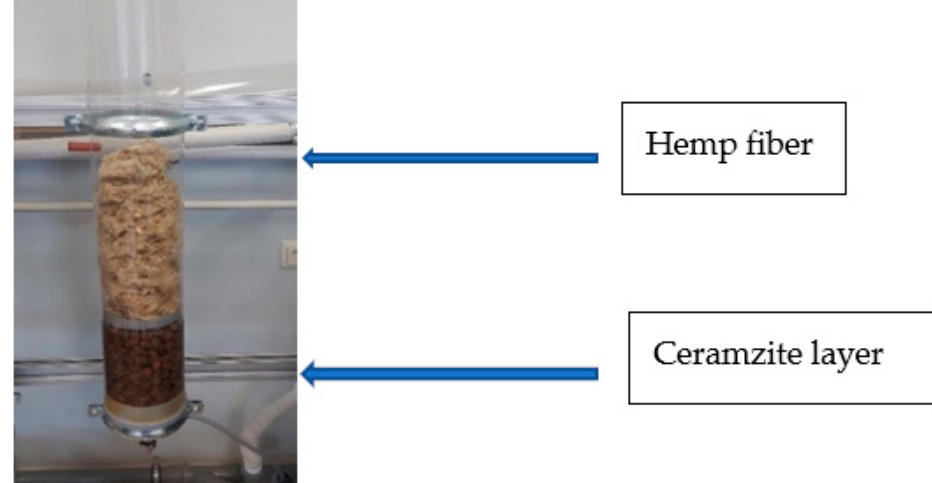
Figure 1. Glass column filled with a ceramzite layer and hemp fiber. Our third experiment evaluated the impact of filter materials on pollution indicators of stormwater contaminated with disinfectants. The control test placed hemp fiber on the ceramzite layer, and the glass column was filled with the stormwater sample. After 30 min contact, the sample was measured for pH, SEL, turbidity and color. In subsequent experiments, 10 mL of disinfectants was added to the jar with stormwater, then test water was mixed and poured into the column. After 30 min contact, pH, SEL, turbidity, color and active chlorine were